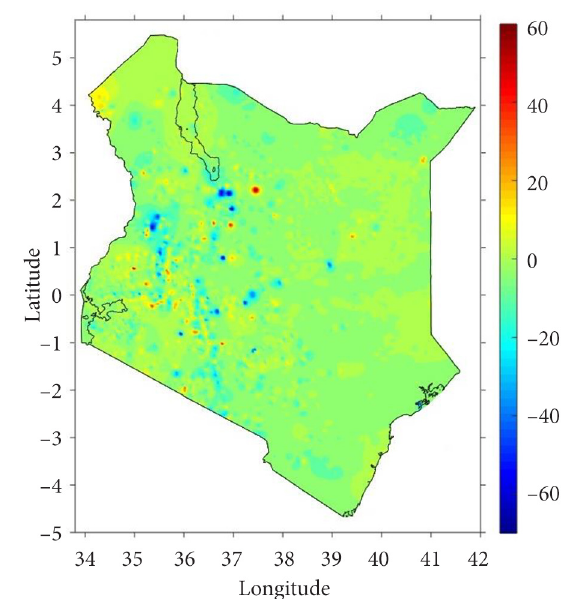
Figure 8. EIGEN-6C4-based gravimetric geoid model, with respect to GRS80, over Kenya (units are in